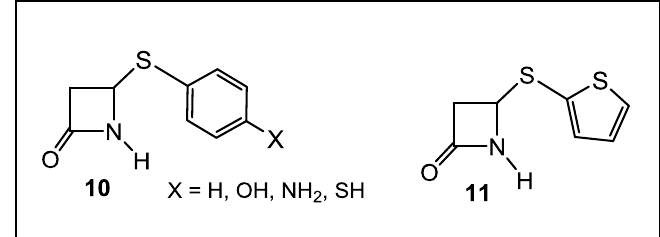
Figure 5. Arylthio-β-lactams active against Moraxella catarrhalis and Mycobacterium tuberculosis